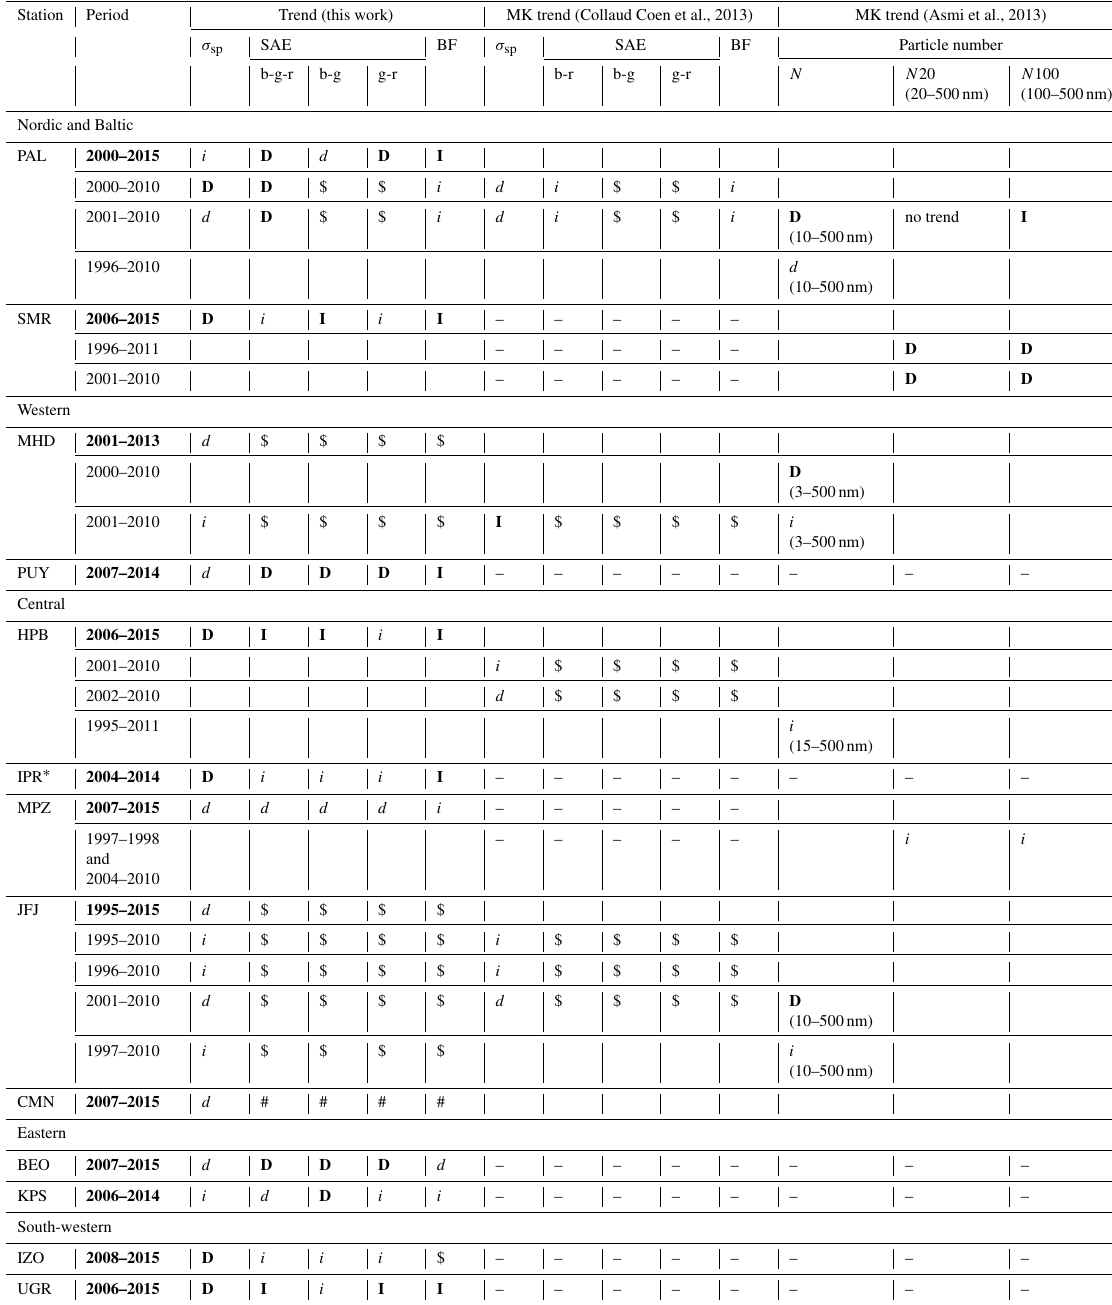
Table 2. Trends of aerosol particle-scattering coefficient ( σ sp ), scattering Ångström exponent (SAE) and backscatter fraction (BF). Three trends for SAE are reported: SAE calculated as a linear fit using three wavelengths (b-g-r), the blue and green wavelengths (b-g) and the green and red wavelengths (g-r). Trend results are reported for the whole period available at each station until 2015 (bold) and for the periods reported in Collaud Coen et al. (2013) and Asmi et al. (2013). Trends are considered statistically significant for a p value of < 0.05. Statistically significant increasing or decreasing trends are highlighted with capital bold I and D letters. Non-statistically significant increasing or decreasing trends are highlighted with lower case italic i and d letters. The dashes in the table cells highlight stations included in this work but not included in the works of Collaud Coen et al. (2013) or Asmi et al. (2013). The symbol $ denotes parameters removed in this work and in the work of Collaud Coen et al. (2013) because of measurement gaps, low data coverage or break points for one or more wavelengths. The symbol # denotes data only available for